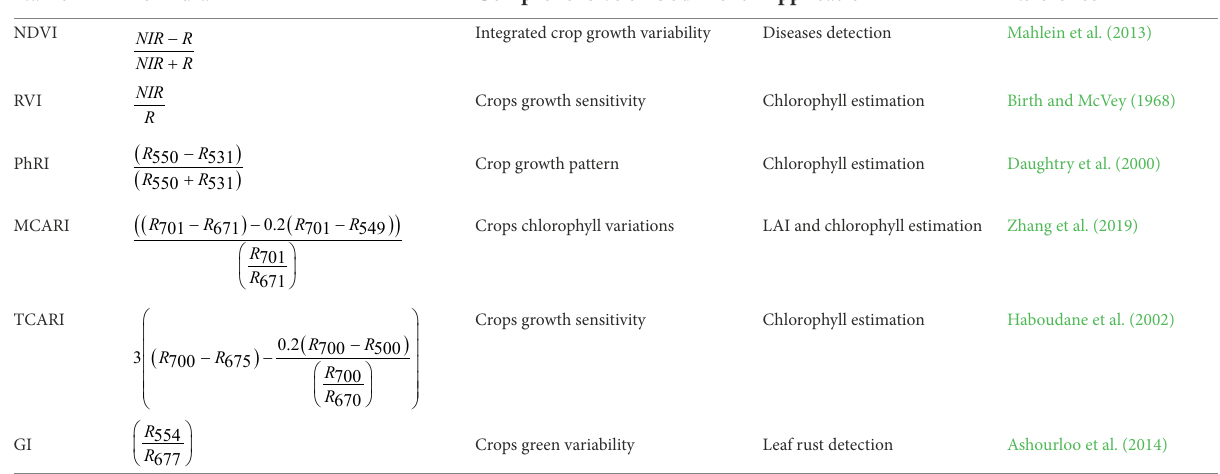
TABLE 1 Vegetation index